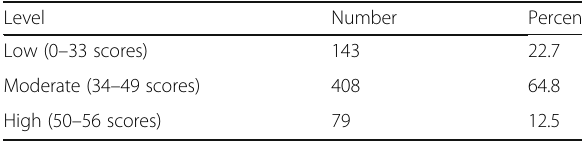
Table 4 Distribution of level of knowledge ( n = 630)